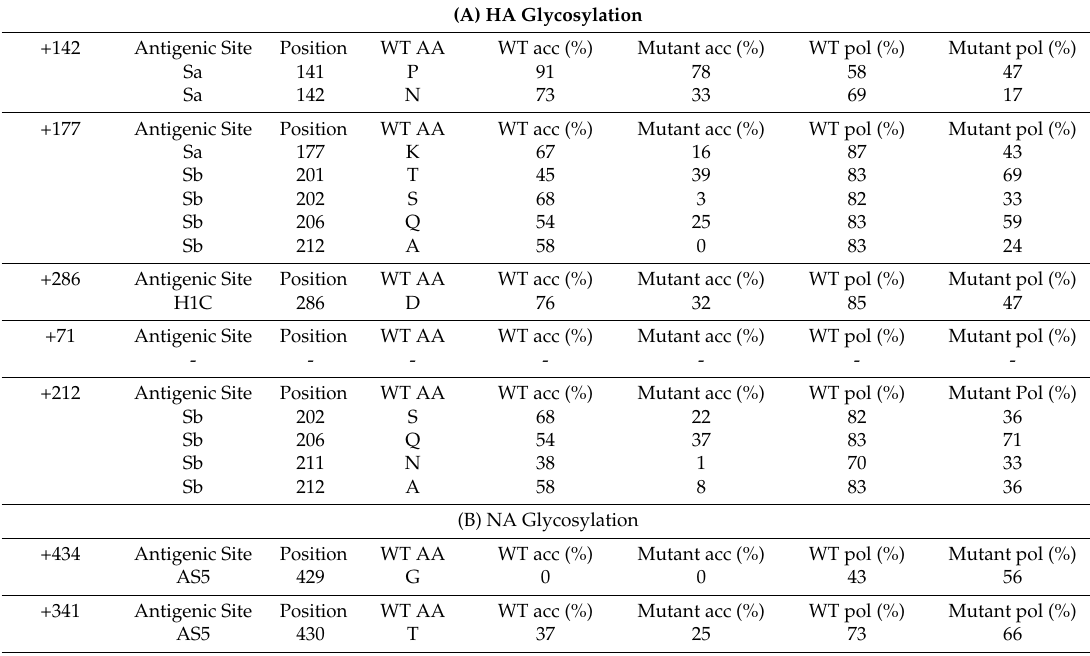
Table 1. Accessible surface areas and polarities in the hemaggluninin (HA) and neuraminidase (NA) antigenic sites of H1N1 pandemic viruses and